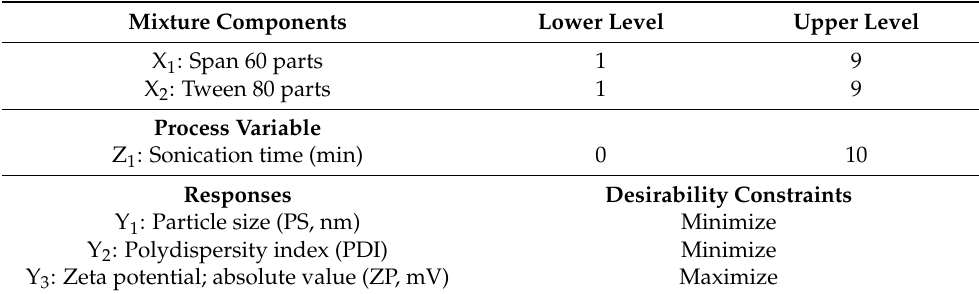
Table 1. MCs and PV with their ranges and response variables with their desirable constraints used in the CMPV design for the development of SMV-SPNs. Mixture Components Lower Level Upper